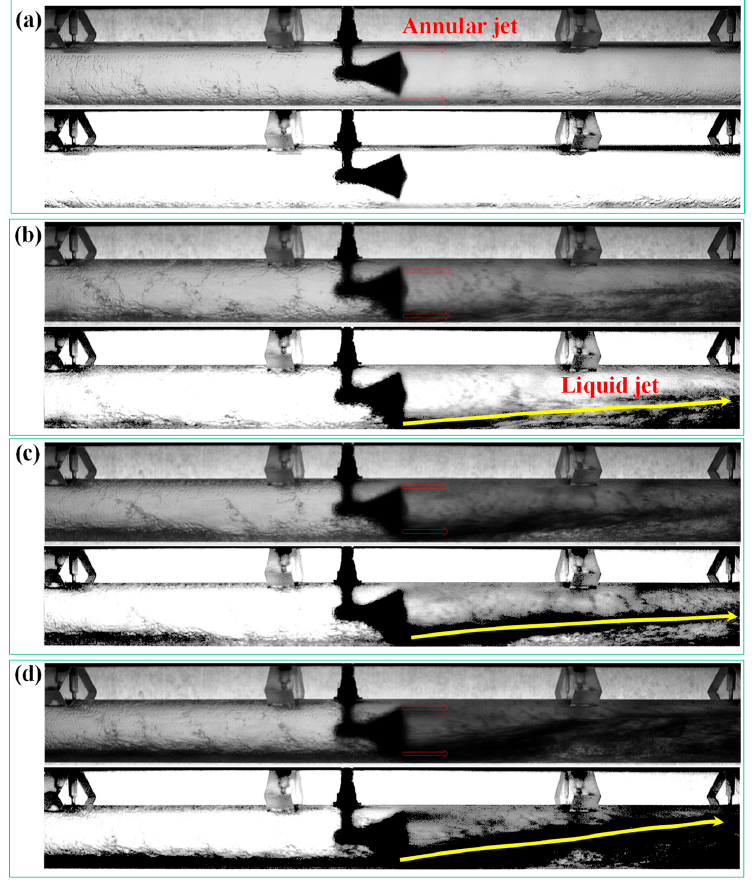
Figure 16. Variation of flow pattern under different superficial liquid velocity ( a ) U sg = 20.6 m·s − 1 , U sl = 0.016 m·s − 1 , GVF = 99.93%; ( b ) U sg = 21.3 m·s − 1 , U sl = 0.13 m·s − 1 , GVF = 99.41%; ( c ) U sg = 20.6 m·s − 1 , − 1 , GVF = 99.93%; ( b ) U − 1 , U · s − 1 , GVF = 99.41%; ( c ) U sg = 20.6 m · s − 1 , sg = 21.3 m · s U sl = 0.26 m·s − 1 , GVF = 98.77%; ( d ) U sg = 20.9 m·s − 1 , U sl = 0.38 m·s − 1 , GVF = 98.23% (up: Enhanced image, U sl = 0.016 m · s sl = 0.13 m U sl = 0.26 m · s − 1 , GVF = 98.77%; ( d ) U sg = 20.9 m · s − 1 , U sl = 0.38 m · s − 1 , GVF = 98.23% (up: Enhanced image, down: Binary image, the videos can be found in Supplementary